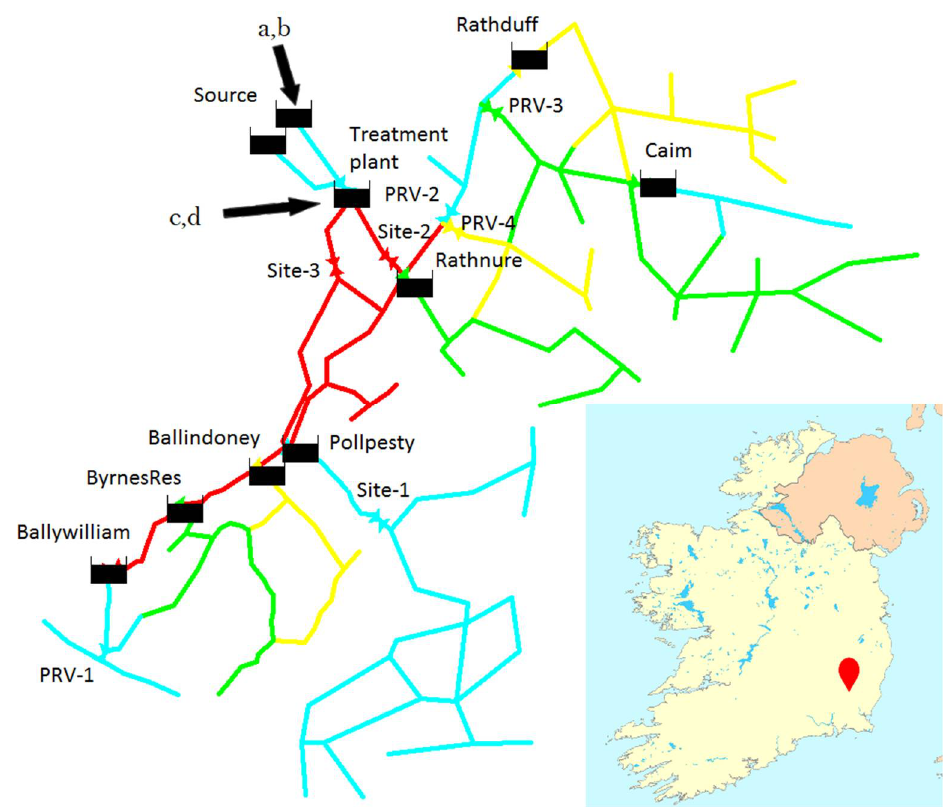
Figure 2. Simplified pipeline layout and geographical location of the Blackstairs Group Water Network in Ireland, with marked locations of items a,b,c,d described in Figure 3. Credits: Minestrone, public domain via Wikimedia Commons.